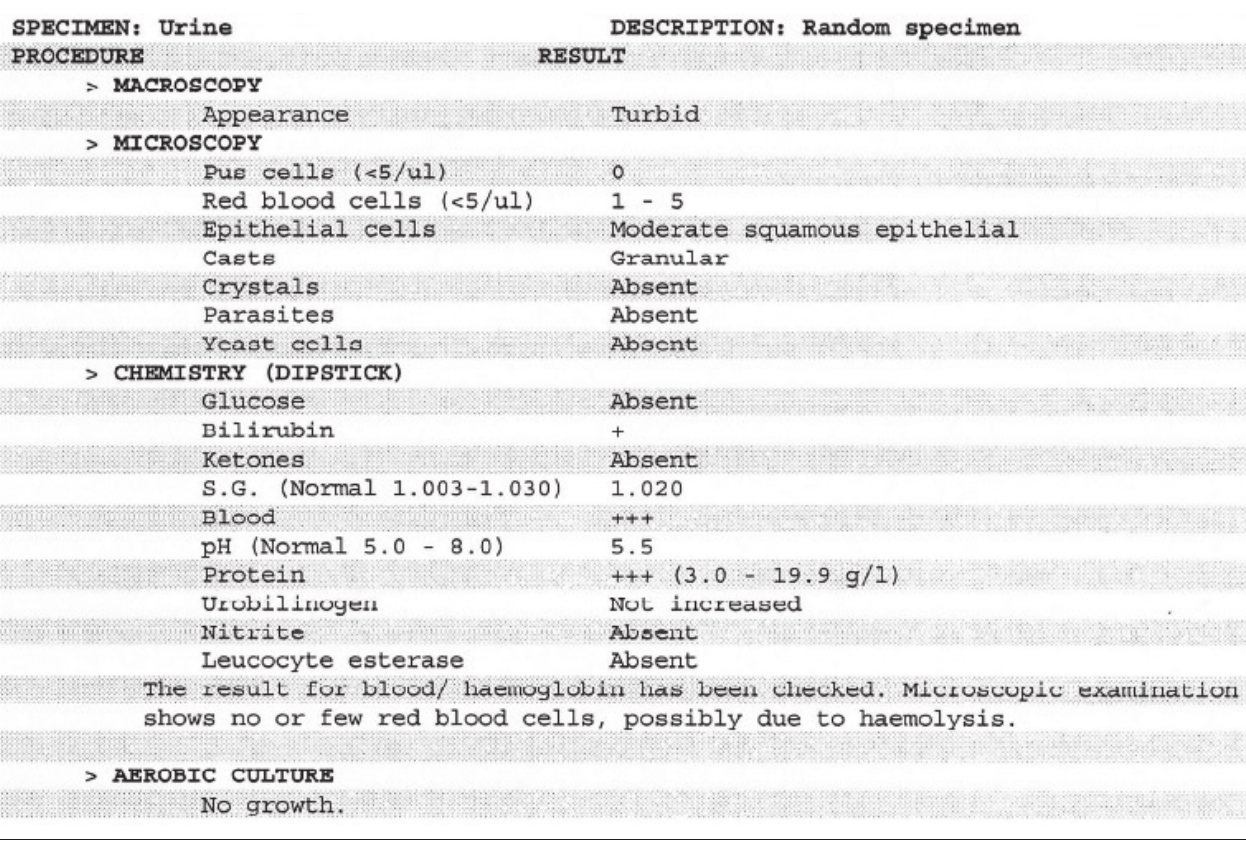
FIGURE 1: Urinalysis of the random urine sample collected at presentation at the emergency